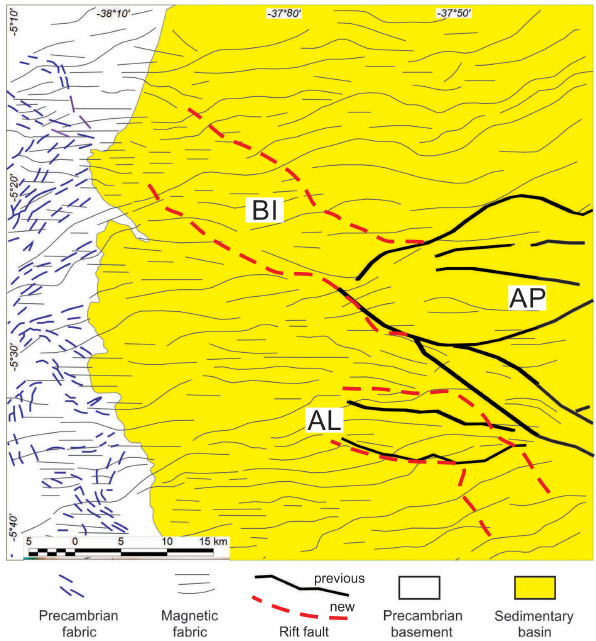
Figure 5. Comparison between Precambrian structural fabric de- rived from remote sensing and NE–SW- to E–W-trending magnetic lineaments. Grabens: BI – Bica; AP – Apodi; and AL – Algodões. provided by the Brazilian Petroleum Agency (ANP). This data set was interpolated with a grid cell size of 500 m using minimum curvature technique (Briggs, 1974).